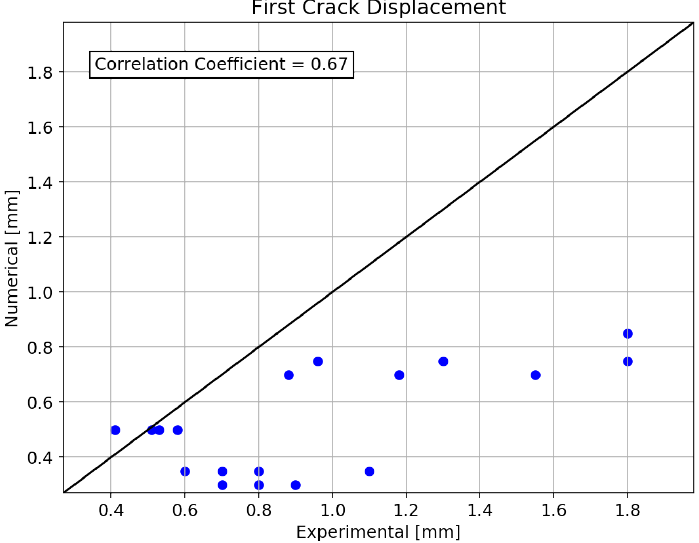
Figure 6. Comparison between numerical and experimental results regarding first- crack